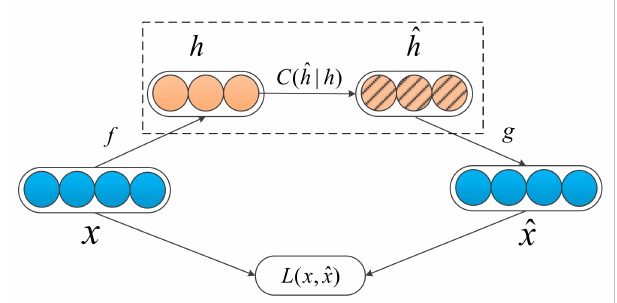
Figure 7. Structure diagram of E-CRBM.